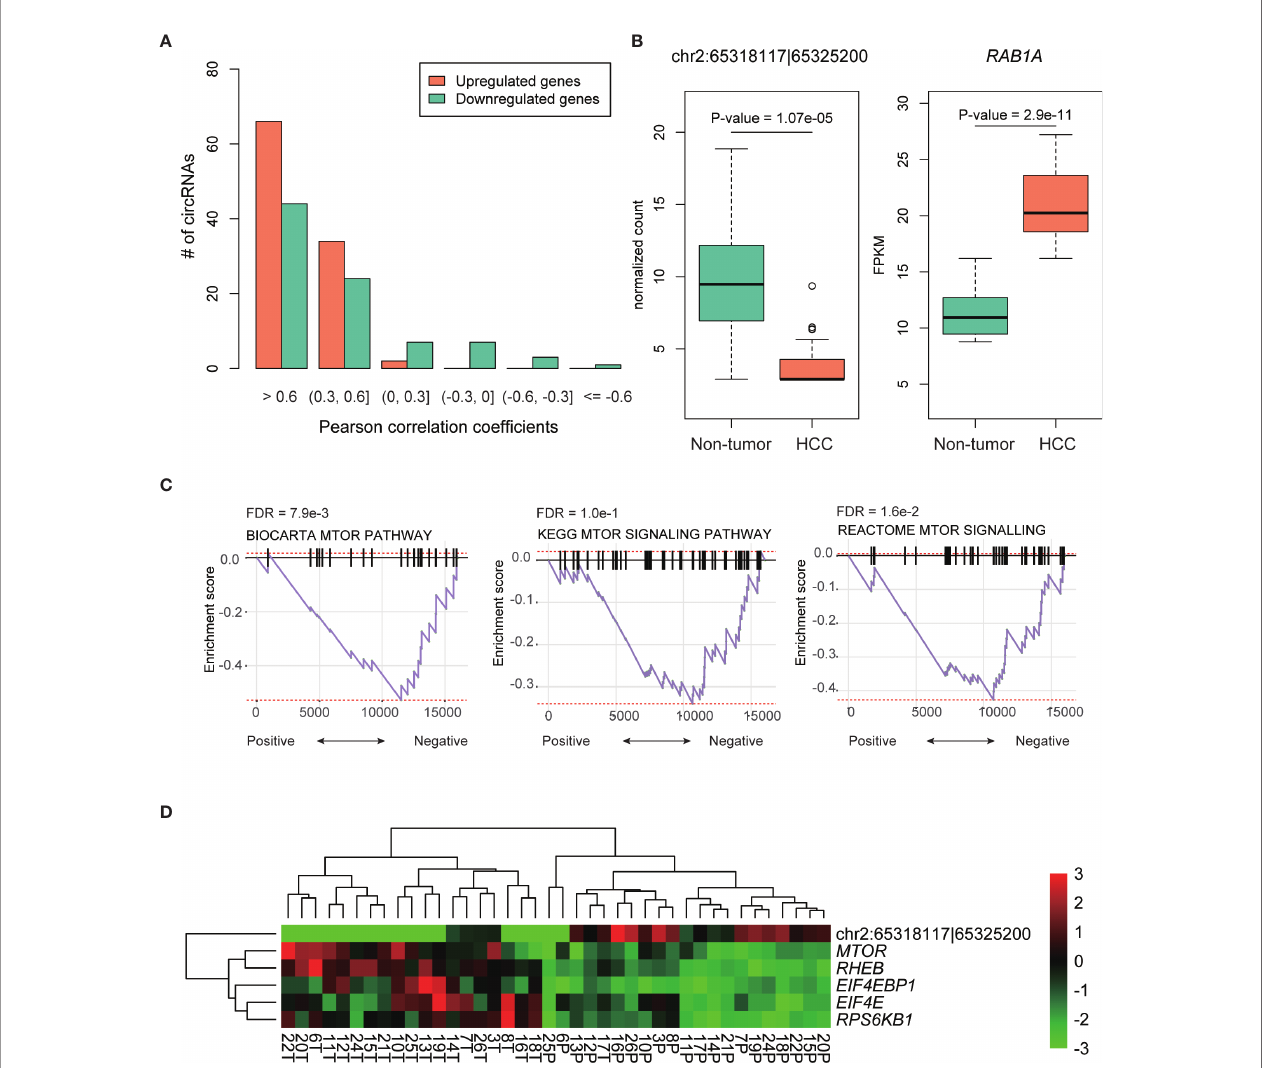
FIGURE 3 | The DE-circRNAs and their parental genes. (A) The distribution of the Pearson correlation coef fi cients between the DE-circRNAs and their parental genes. (B) The expression patterns of hsa_circ_0141900 and RAB1A in HCC and non-tumors. (C) The signi fi cance of the mTOR signaling pathway enriched by the highly correlated genes with hsa_circ_0141900 by GSEA. (D) The expression pro fi les of the highly correlated genes with hsa_circ_0141900in mTOR signaling